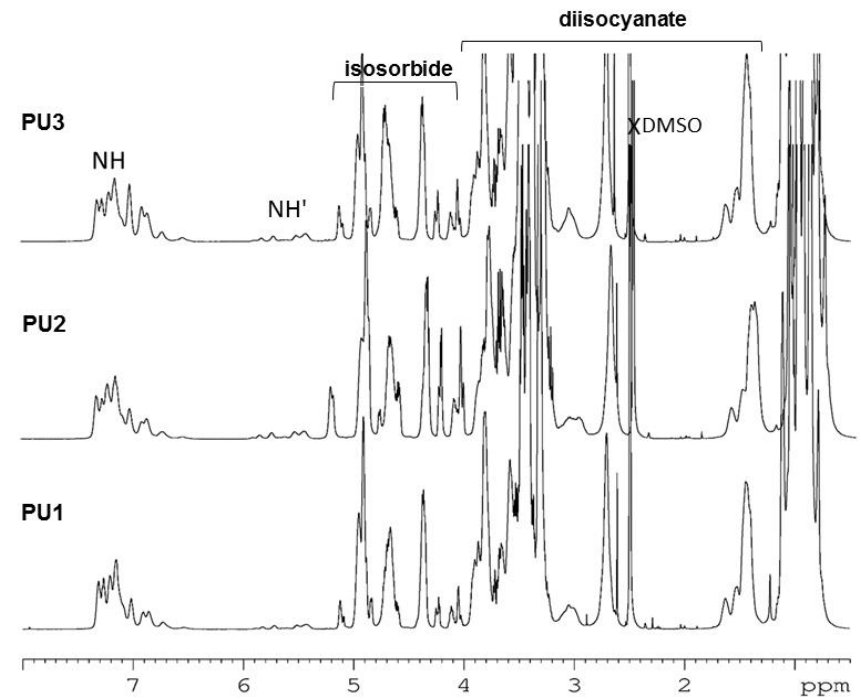
Figure 6. The 1 H NMR spectra of PU1 , PU2 , and PU3 in DMSO- d 6 . Protons of the terminal groups are primed.